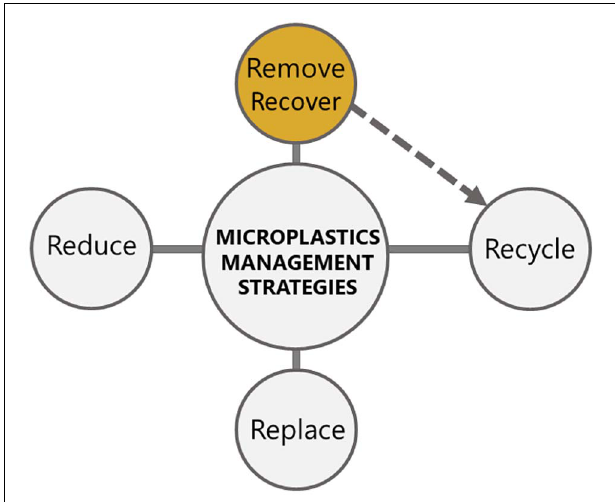
FIGURE 1 | Currently used microplastics mitigation strategies. The recycling strategies are dependent on the efficient removal and recovery of microplastics, which is indicated with a dashed arrow. Our research proposes to invest into development of novel removal strategies, as for example by using jellyfish mucus (colored in